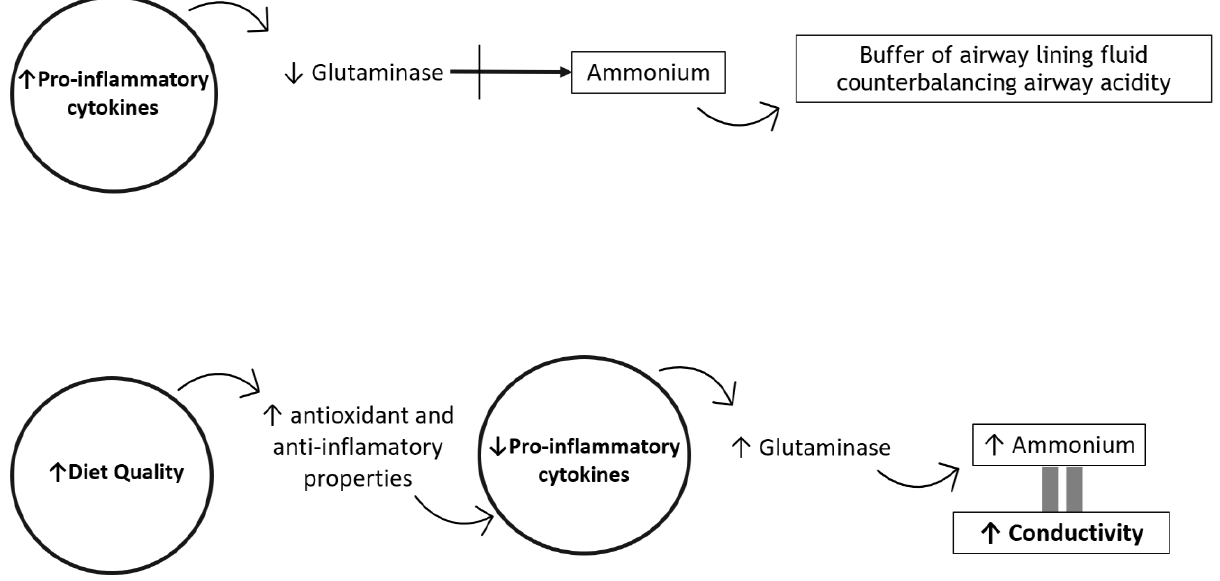
Figure 2. Hypothetical mechanisms by which diet quality may influence EBC conductivity. Pro- inflammatory cytokines decrease glutaminase activity in airway epithelial cells. Glutaminase is responsible for ammonium production, which is considered a buffer of airway acidity. A higher diet quality may provide several dietary components with antioxidant and anti-inflammatory properties that decrease the production of pro-inflammatory cytokines, contributing to normal glutaminase activity and ammonium production, which is reflected in the higher conductivity of the exhaled breath condensate.